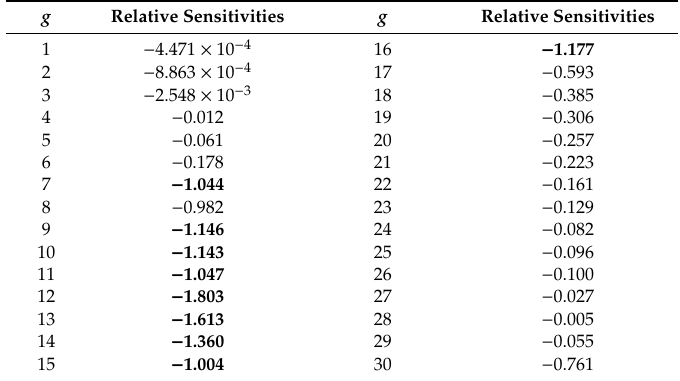
(cid:16) (cid:17) N 5,2 , σ g , g = 1, ... ,30. t ,1